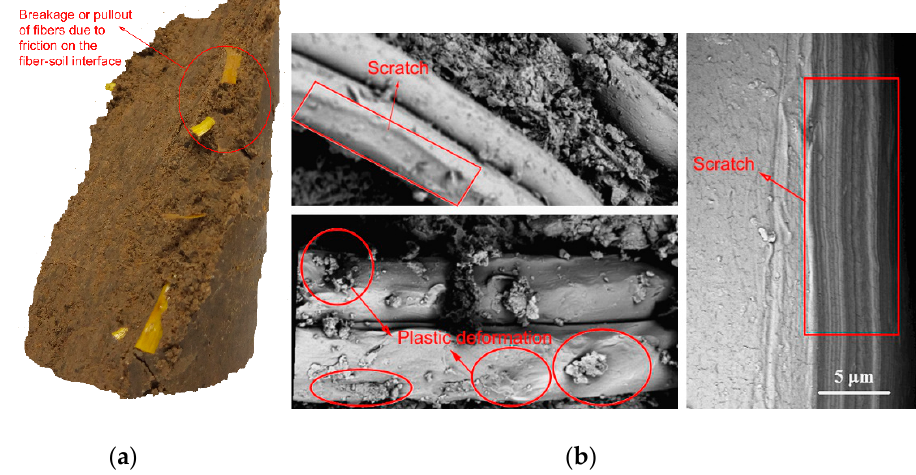
Figure 9. Experimental evidence of friction between fiber and soil showing ( a ) breakage or pullout of fibers and ( b ) a scratch formed on the fiber surface (modified from Tang et al. (2007) [64] and Tang et al. (2010) [65]).